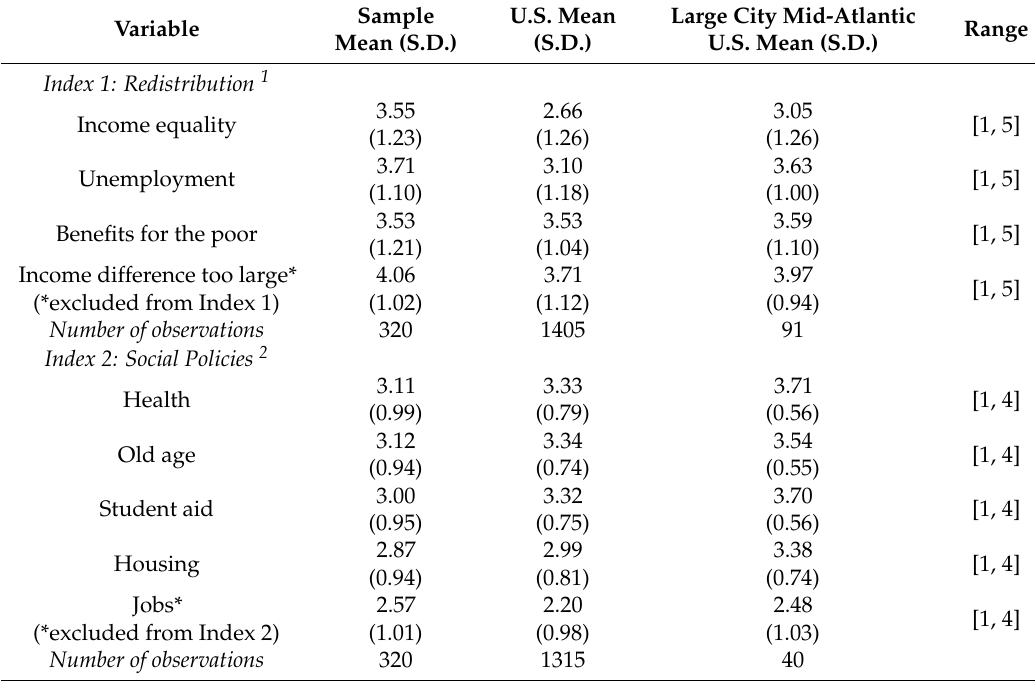
Table 2. Mean support for social